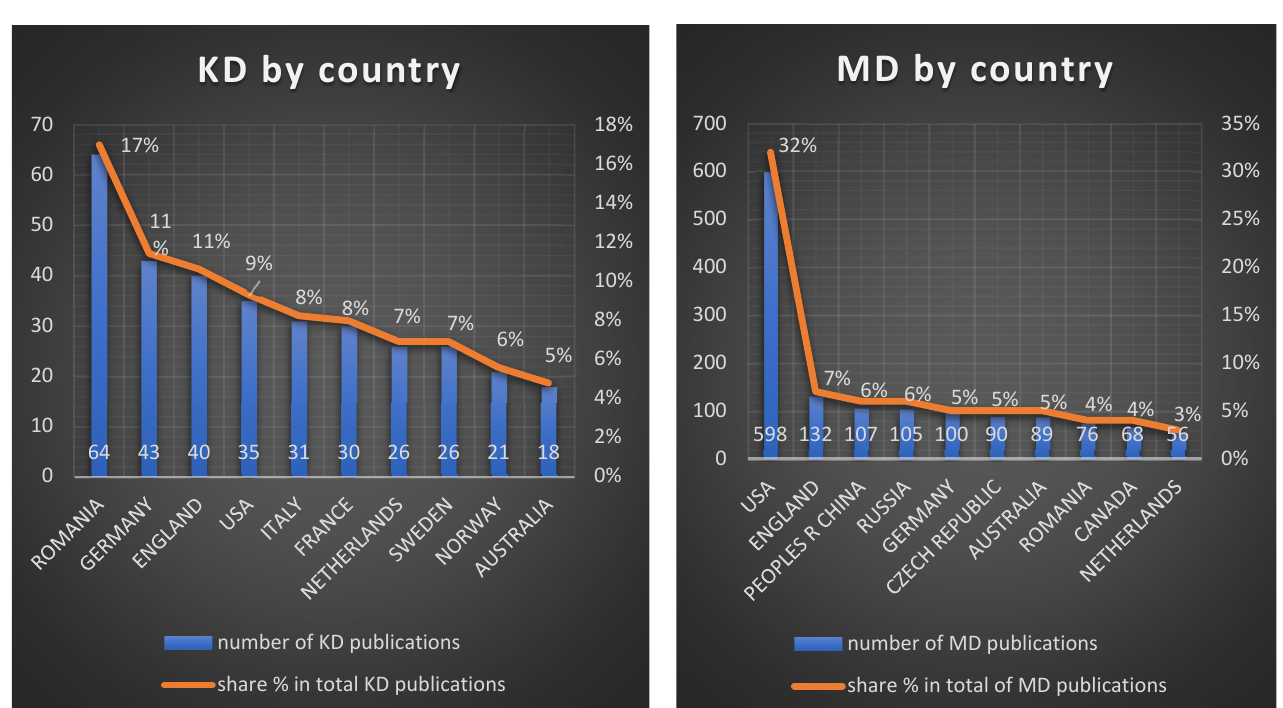
Figure 1. Top 10 KD and MD by country with shares in related publications—by VOSviewer (Source: authors’ own research).